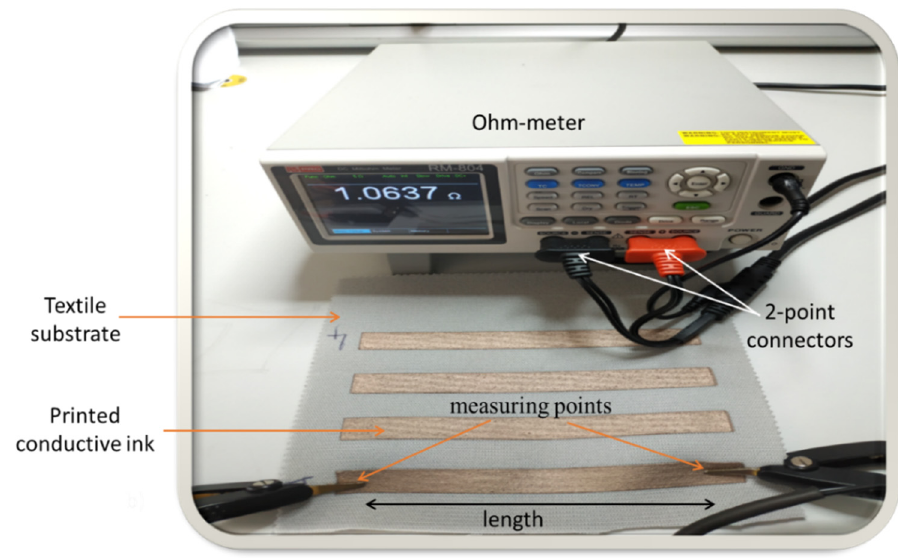
Figure 11. Experimental setup used for measurement of the electrical resistance.